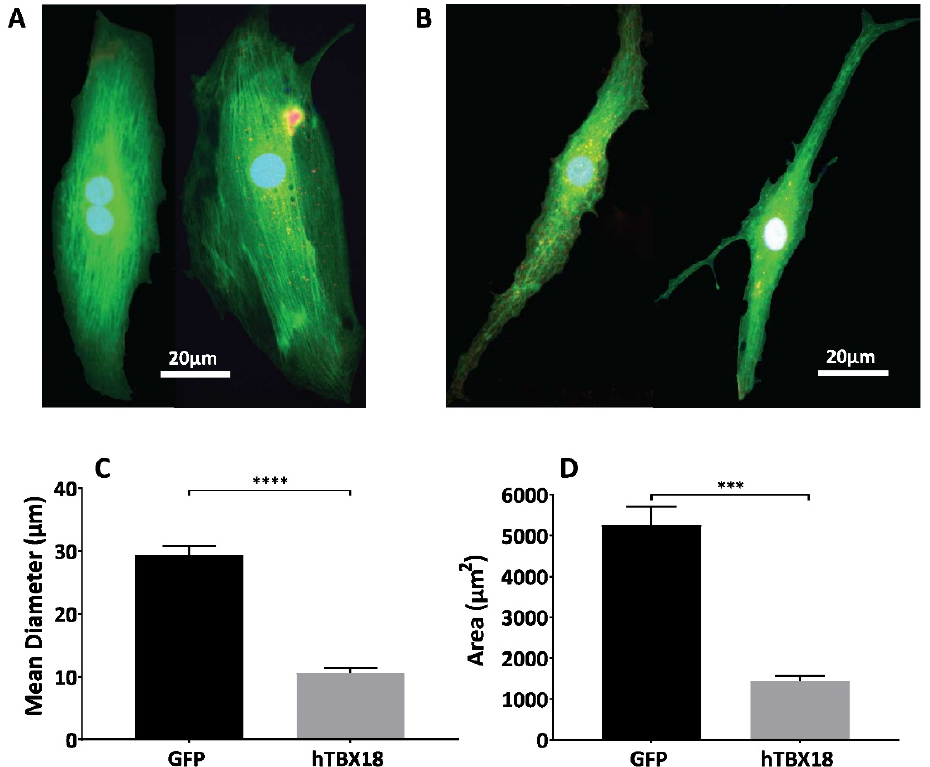
Figure 5. Morphological characterization of NRVMs converted to a pacemaker cell phenotype following induced overexpression of hTBX18 . ( A ) Representative figures showing original NRVMs with their characteristic large, thick, block-like structure. ( B ) Representative figures showing rAAV6- hTBX18 -transduced NRVMs which have become thin, spindle-like and tapering in structure after 3 weeks. ( C ) Quantification of the mean diameter of the transduced cells. ( D ) Quantification of the mean area of the transduced cells. Data presented as mean ± SEM. **** p -value ≤ 0.0001, *** p -value ≤ 0.001.